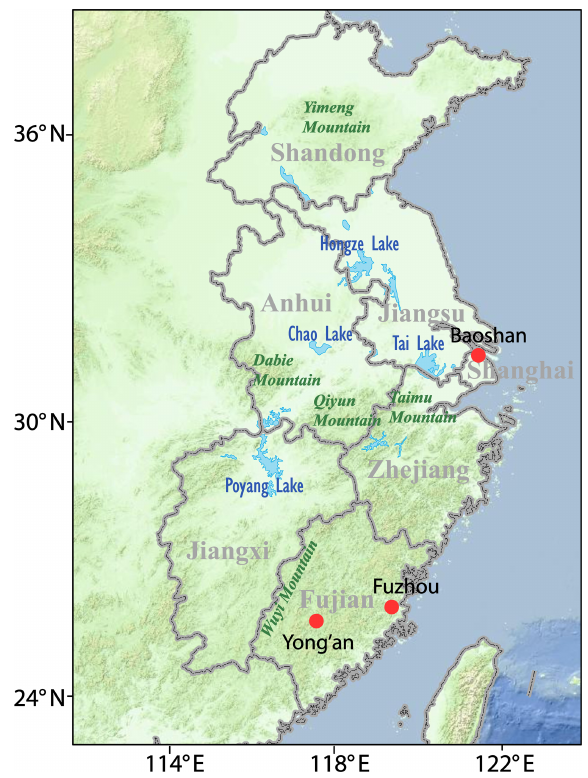
Figure 1. The map of research area, topography, major lakes, and mountains in eastern China. The red circles denote the locations of three pyranometers (Baoshan, Fuzhou, and Yong’an). This figure was generated by ArcGIS, version 10.2. Map source: Map World (National Platform for Common Geospatial Information Services, http://www.tianditu.gov.cn/, last access: 1 November